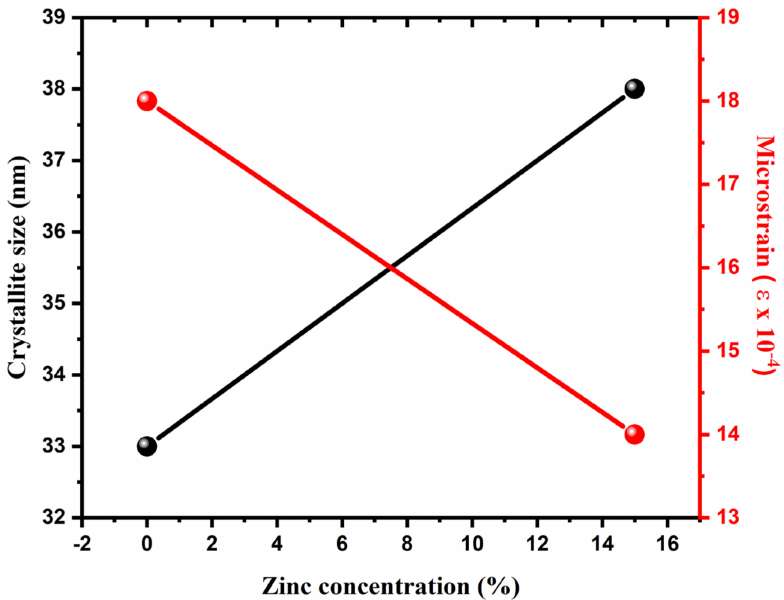
Figure 4. Analysis of microstructural parameters, such as crystallite size D and micro-strain ( ε ), with respect to Zinc concentration for the synthesized